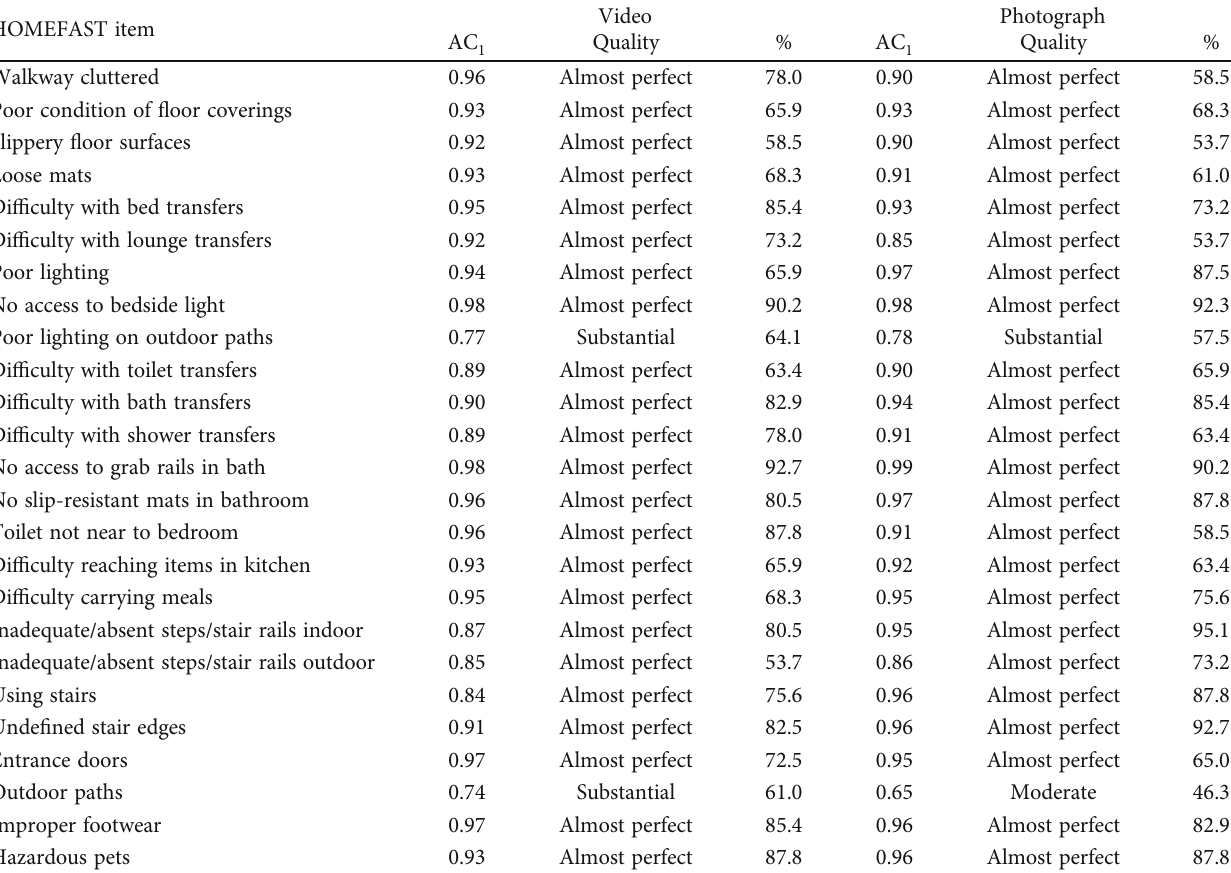
Table 3: Interrater agreement of HOME FAST on video and photographs evaluation.